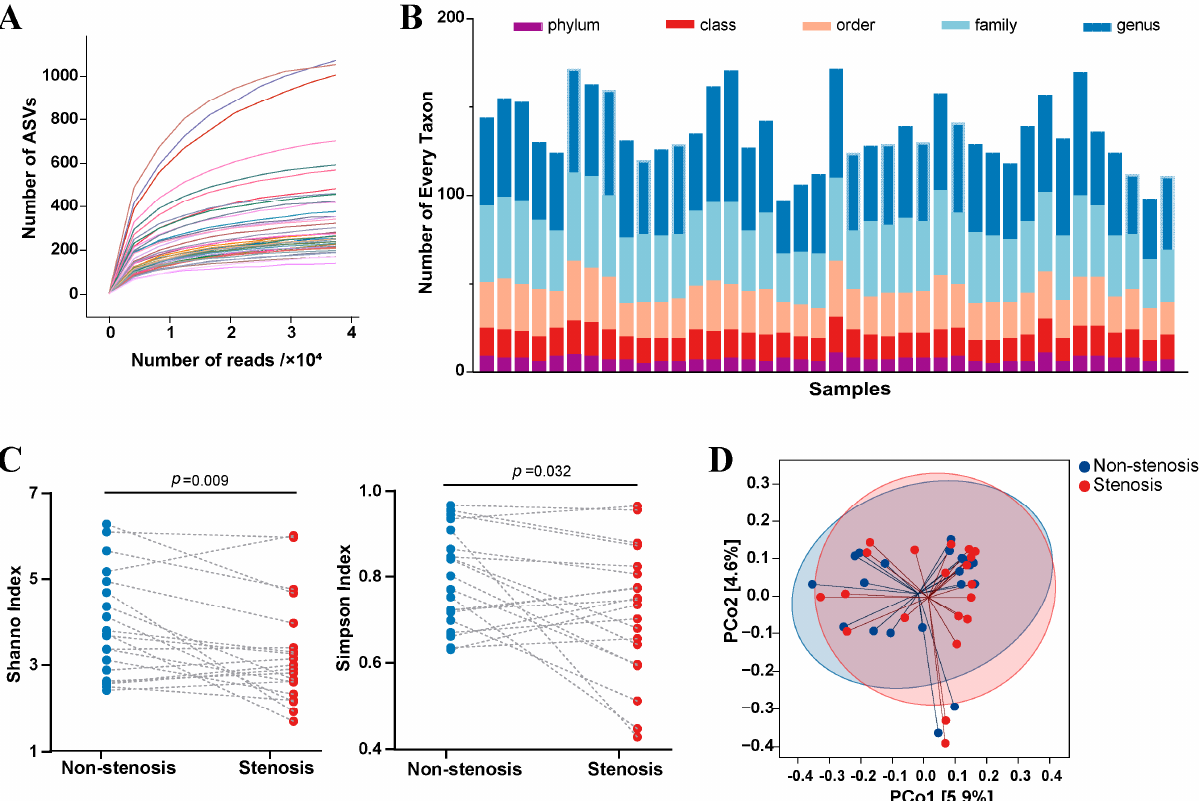
Figure 1. Mucosa-associated microbiota variations between intestinal stenotic and non-stenotic sites in CD. ( A ): Dilution curve representing the relationship between number of gene reads and amplicon sequence variants. Every curve represents a sample; ( B ): Number of different taxonomic levels in every sample; ( C ): Alpha diversity variations in different sites of every patient; ( D ): Principal Coordinates Analysis between samples from stenotic and non-stenotic sites.